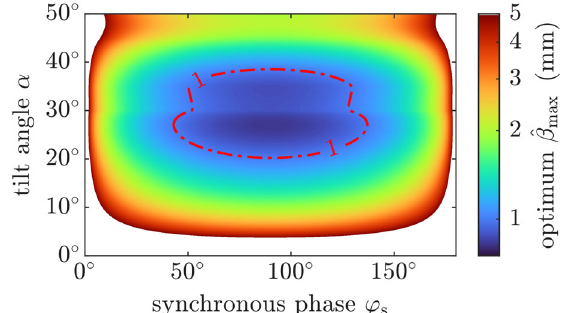
ˆ β FIG. 7. Maximum of the betafunction for a matched beam max in a synchronous DLA undulator with E 0 ¼ 10 GV = m laser field π = 2 and strength at optimum FODO cell length. The absolute minimum of s ¼ ˆ β π = 2 implies K sync at φ ¼ 0 s ¼ max und